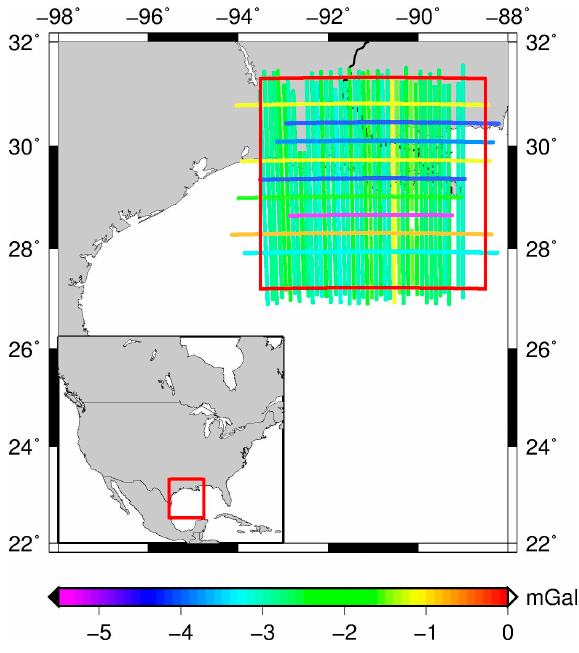
Figure 1. The distribution of the bias from EGM08 of the airborne gravimetry lines in Louisiana (the North-South lines are the survey lines, the West-East lines are the cross lines with the significant errors). Table 1. Difference between GGMs derived values and the airborne gravity disturbances of the Louisiana gravity project (mgal).